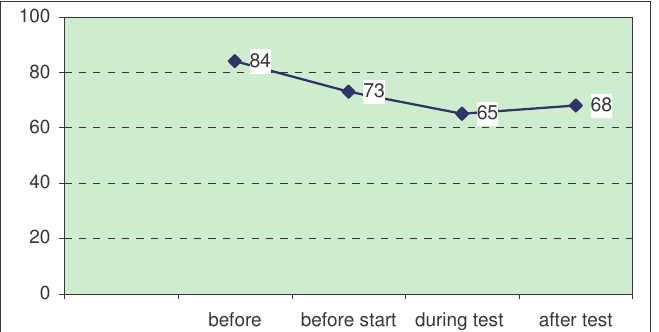
Figure 2. Development in ISA acceptance in % of test drivers